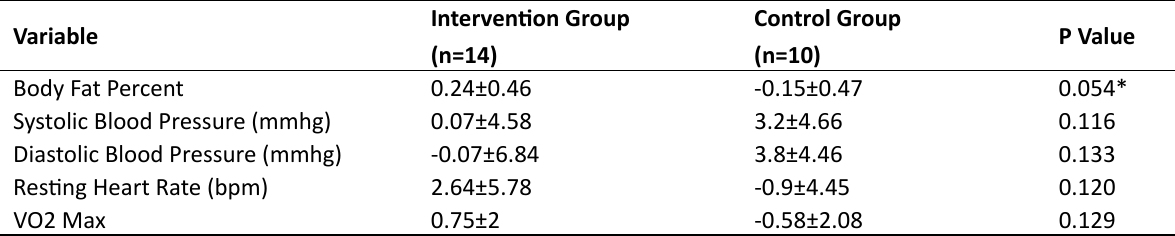
Table 3. Comparison of Physical Parameters after 12 weeks (Difference between Post and Pre-Scores, Independent T Test)